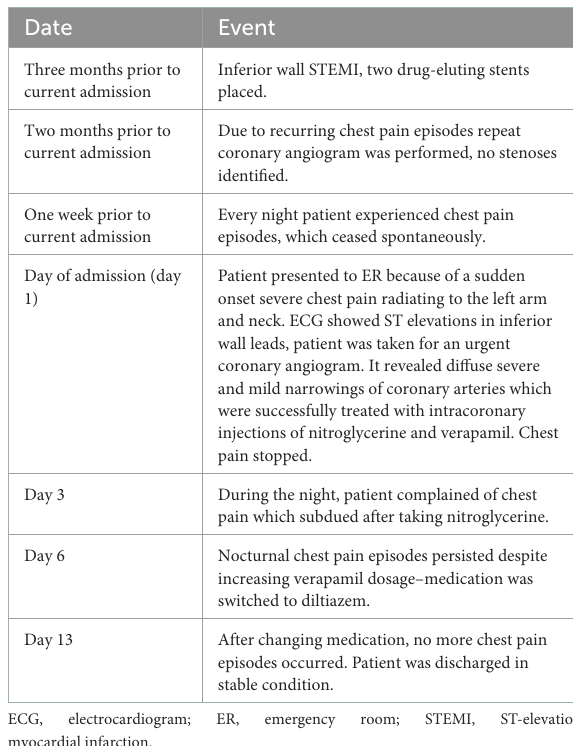
TABLE 1 Timeline of the clinical